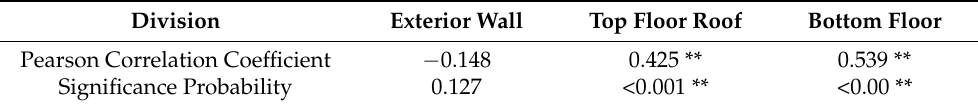
Table 9. Pearson correlation between heat resistance and survey